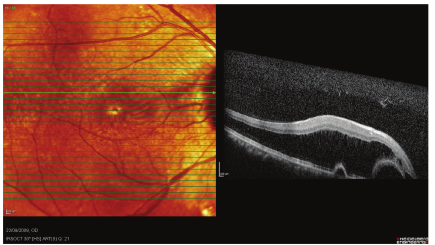
Figure 4: Spectralis OCT showing cystoid macular edema with di ff use inner retinal thickening and two areas of pigment epithelial detachment superior to the